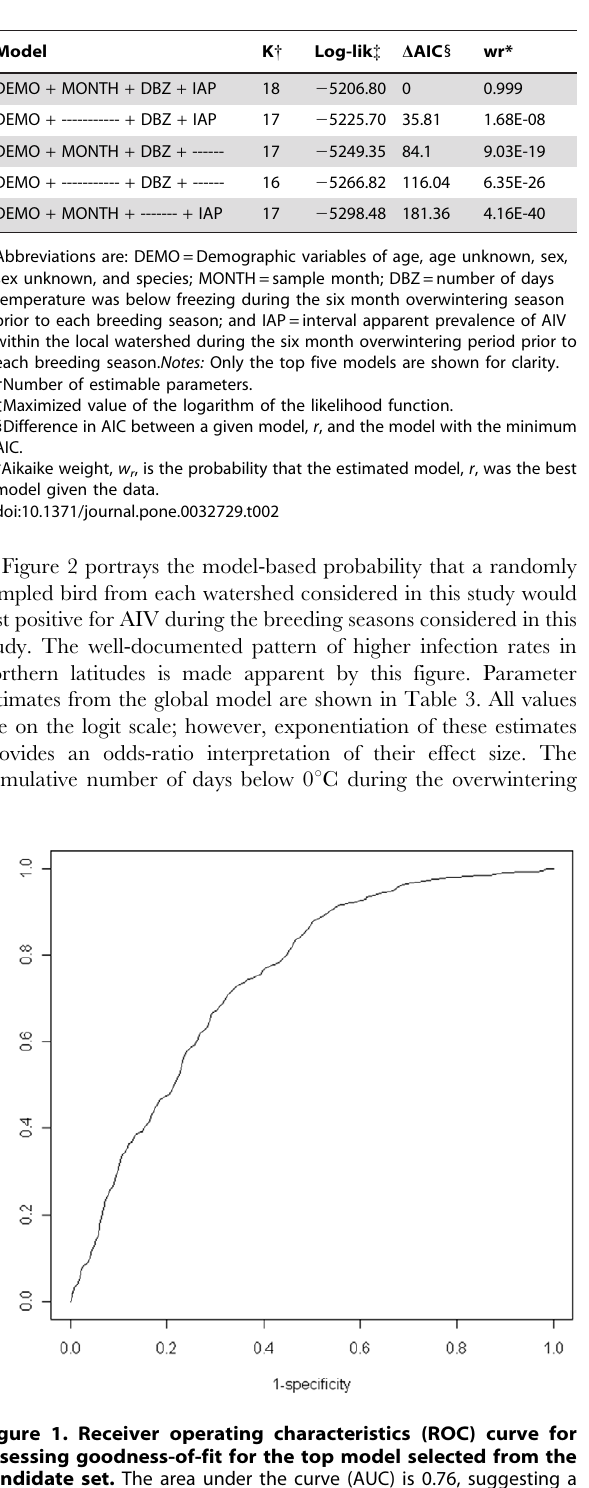
Table 2. Candidate set of models used to identify the relative influence of covariates on the probability an individual bird sampled during the breeding season tested positive for Avian Influenza Virus